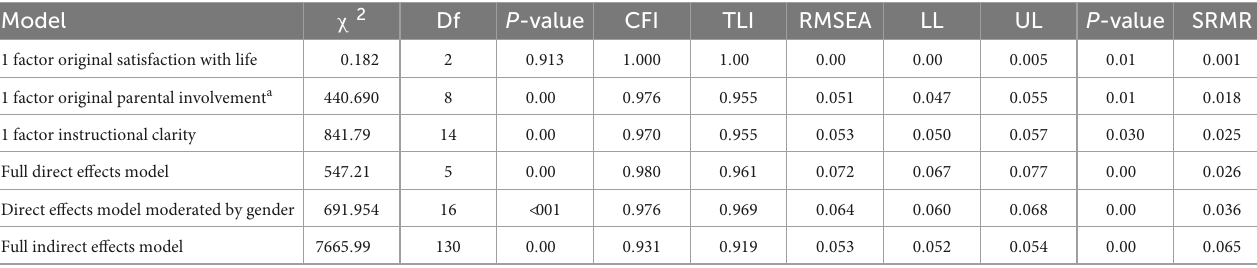
TABLE 2 Summary of fit indices of measurement and structural models.